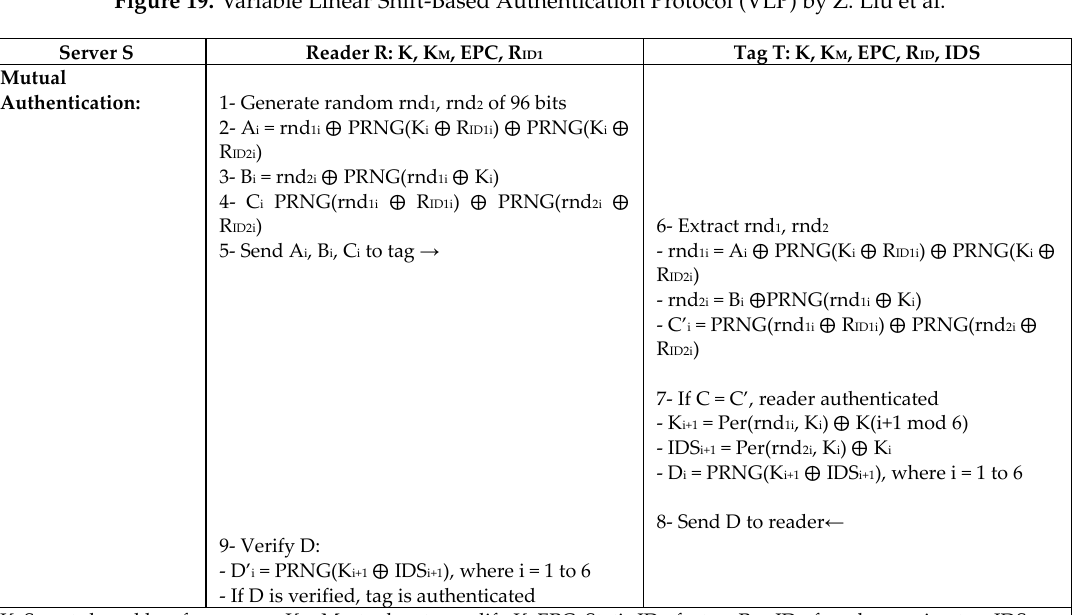
Figure 19. Variable Linear Shift-Based Authentication Protocol (VLP) by Z. Liu et al.